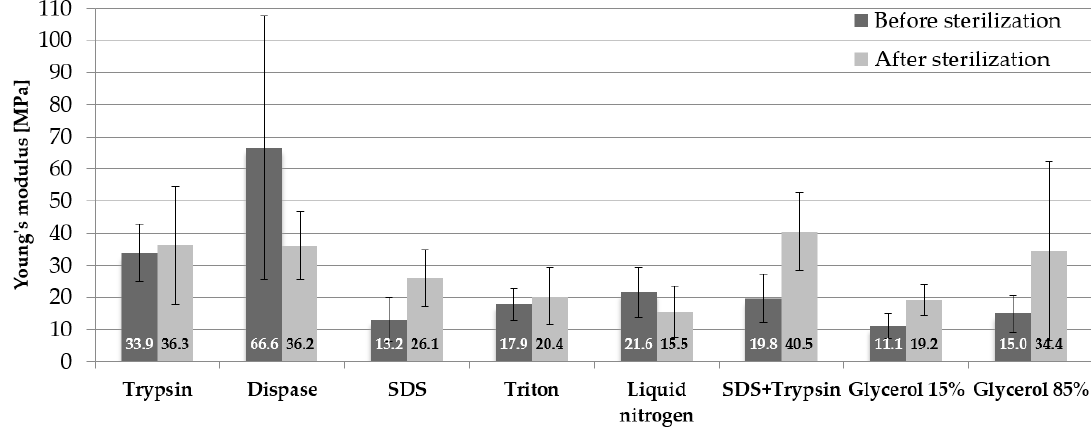
Figure 5. Mean values of Young’s modulus.